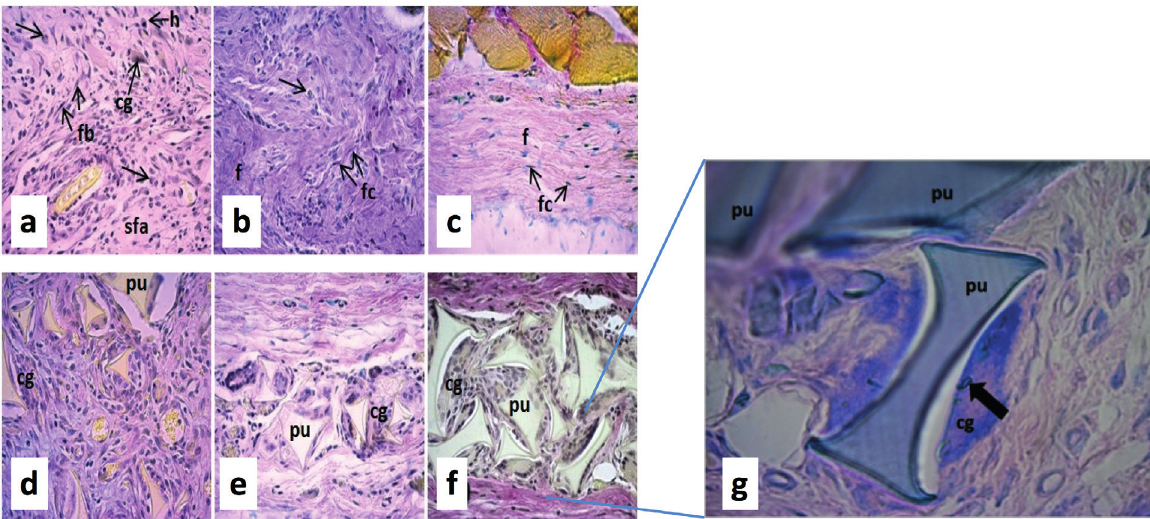
Figure 2 - Panoramic images representative of histological sections of the dorsal skin of rats at 7, 30, or 90 days after surgery in animals from the Sham ( a-c ) or PU ( d-f ) groups, stained by Vanderbilt coloring at 400X magnification. In the Sham group, ( a ) during the acute phase of inflammatory response, intense cellularity is observed in the hypodermis, with high presence of histiocytes (h), FBGC (cg), mononuclear (arrows) and fibrocytes (fb) responsible for the production of ground substance (sfa); all these aspects are indicating the initial phase of the healing process. ( b ) At day 30, the inflammatory process is still active in this group, but a tendency toward cellular density reduction can be observed, with higher presence of fibrocytes (fc) and collagen fibers (f), which reflects a fine evolution of tissue regeneration. ( c and f ) Chronic phase of the inflammatory response (day 90), showing a remarkable presence of collagen fibers in both groups, at the same extent and similar thickness, reflecting desirable tissue regeneration and complete healing. ( d, e ) Contrasting with the Sham group, PU-implanted animals showed a higher number of FBGC surrounding this material, which is suggestive of intense innate immune response to it. ( g ) FBGC nature of these cells and their role in the degradation of the material seems to be acceptable, since in photomicrography of representative histological section from animal samples, at 90-day after the implant, stained by Giemsa coloring, at 1000X magnification, multinuclear structure and polyurethane fragments (pu) can be observed inside the cytoplasm